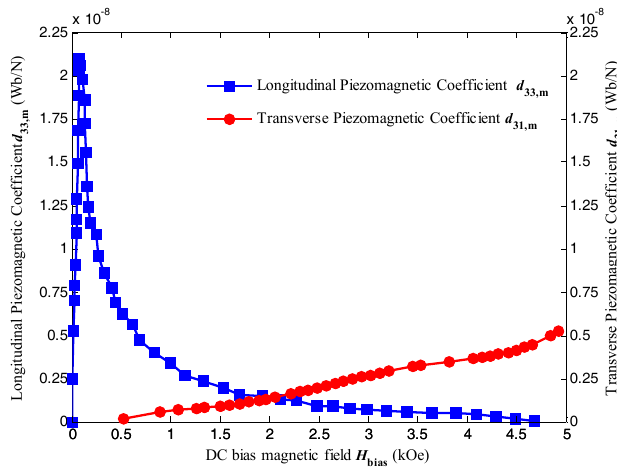
Figure 7. The longitudinal piezomagnetic coefficient d 33,m and transverse piezomagnetic coefficient d 31,m of Terfenol-D as a function of the DC bias magnetic field H bias , which are the respective slopes calculated from the corresponding magnetostriction curves in Figure 6.